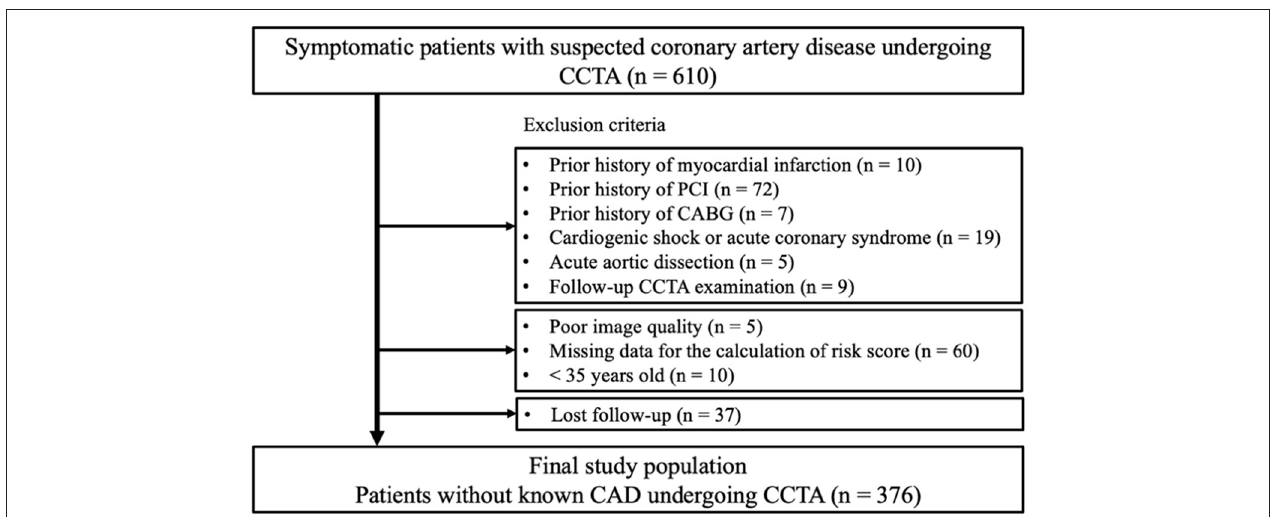
FIGURE 1 | Flow chart for the study population. ACS, acute coronary syndrome; CAD, coronary artery disease; CCTA, coronary computed tomography angiography; CABG, coronary artery bypass graft; PCI, percutaneous coronary